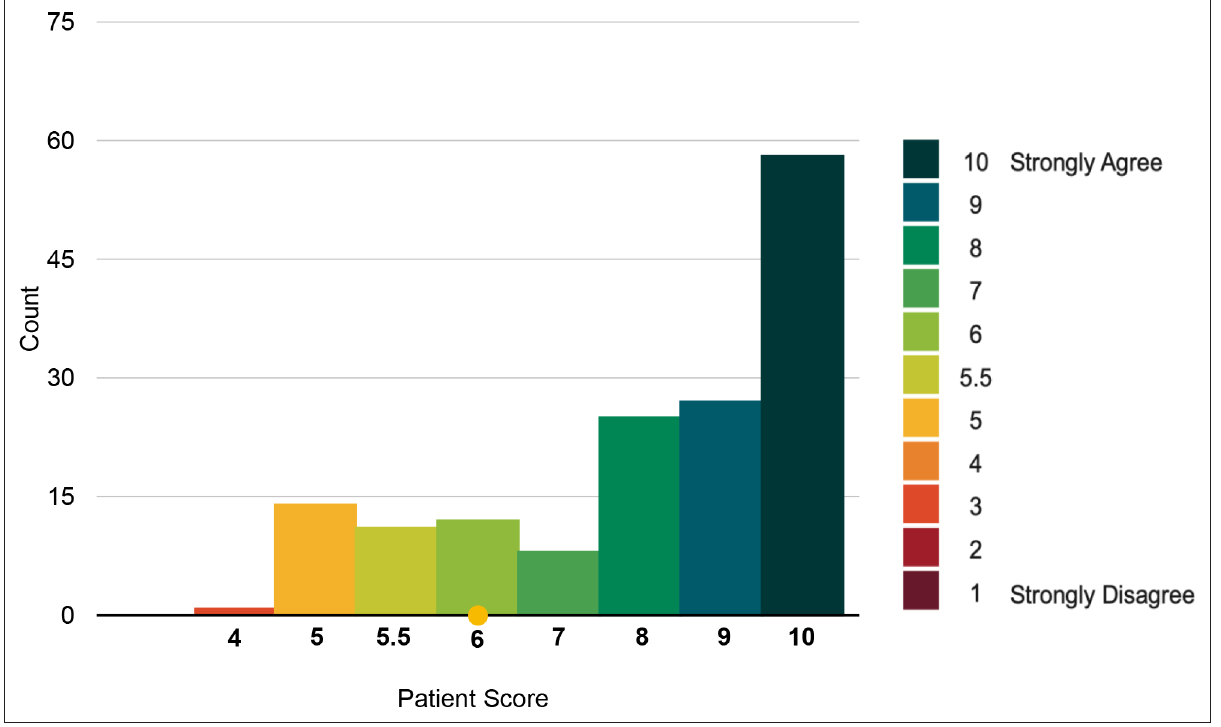
Figure 2 Distribution of scores patients provided regarding their agreement with statement, ' Overall, I was happy with the type of consultation used for my Living Well Assessment '. Proportionally, a greater number of video- call patients (24.4%) were unhappy with their consultation type, in comparison with telephone patients (13.7%) and home- visit patients (12.1%). The difference in scores according to method was non- significant, χ 2 (2, n = 147) =4.5, P =